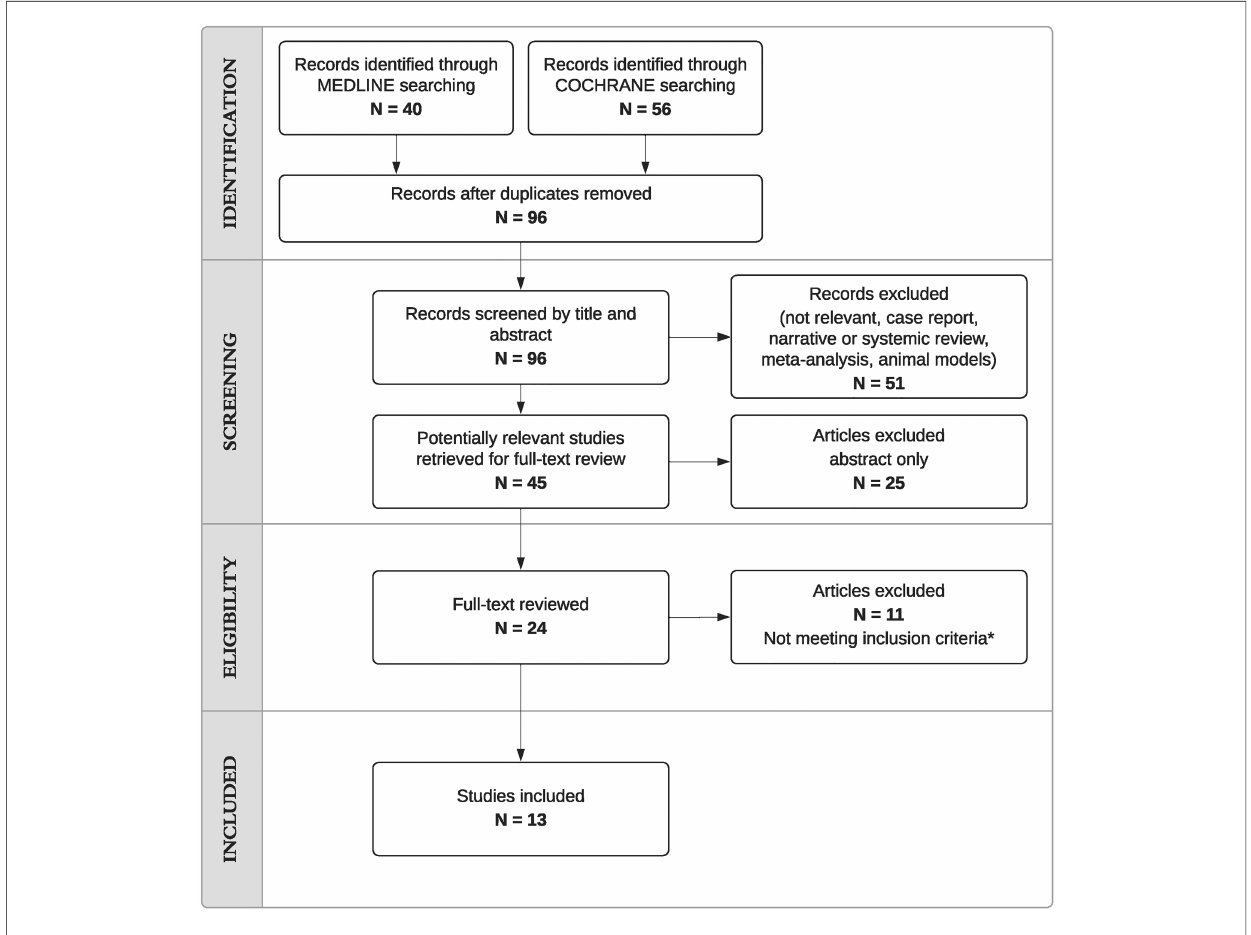
FIGURE 1 Flow chart of the study selection